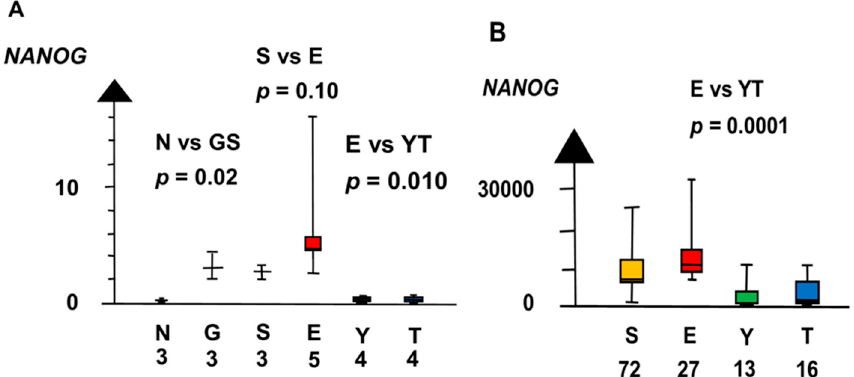
Figure 4. RNA expression of NANOG in the second microarray and the RNAseq dataset ( A , B ) show that germ cell neoplasia in situ (G), seminoma (S), and embryonal carcinoma (E) had a high RNA expression and that yolk sac tumor (Y) and teratoma (T) had a low RNA expression. SE had a set of overexpressed genes that differed from that in GCNIS. The RNA expression of CCND2, KLF4 , and POU5F1 was high in SE but low in GCNIS. Furthermore, SE had a downregulated